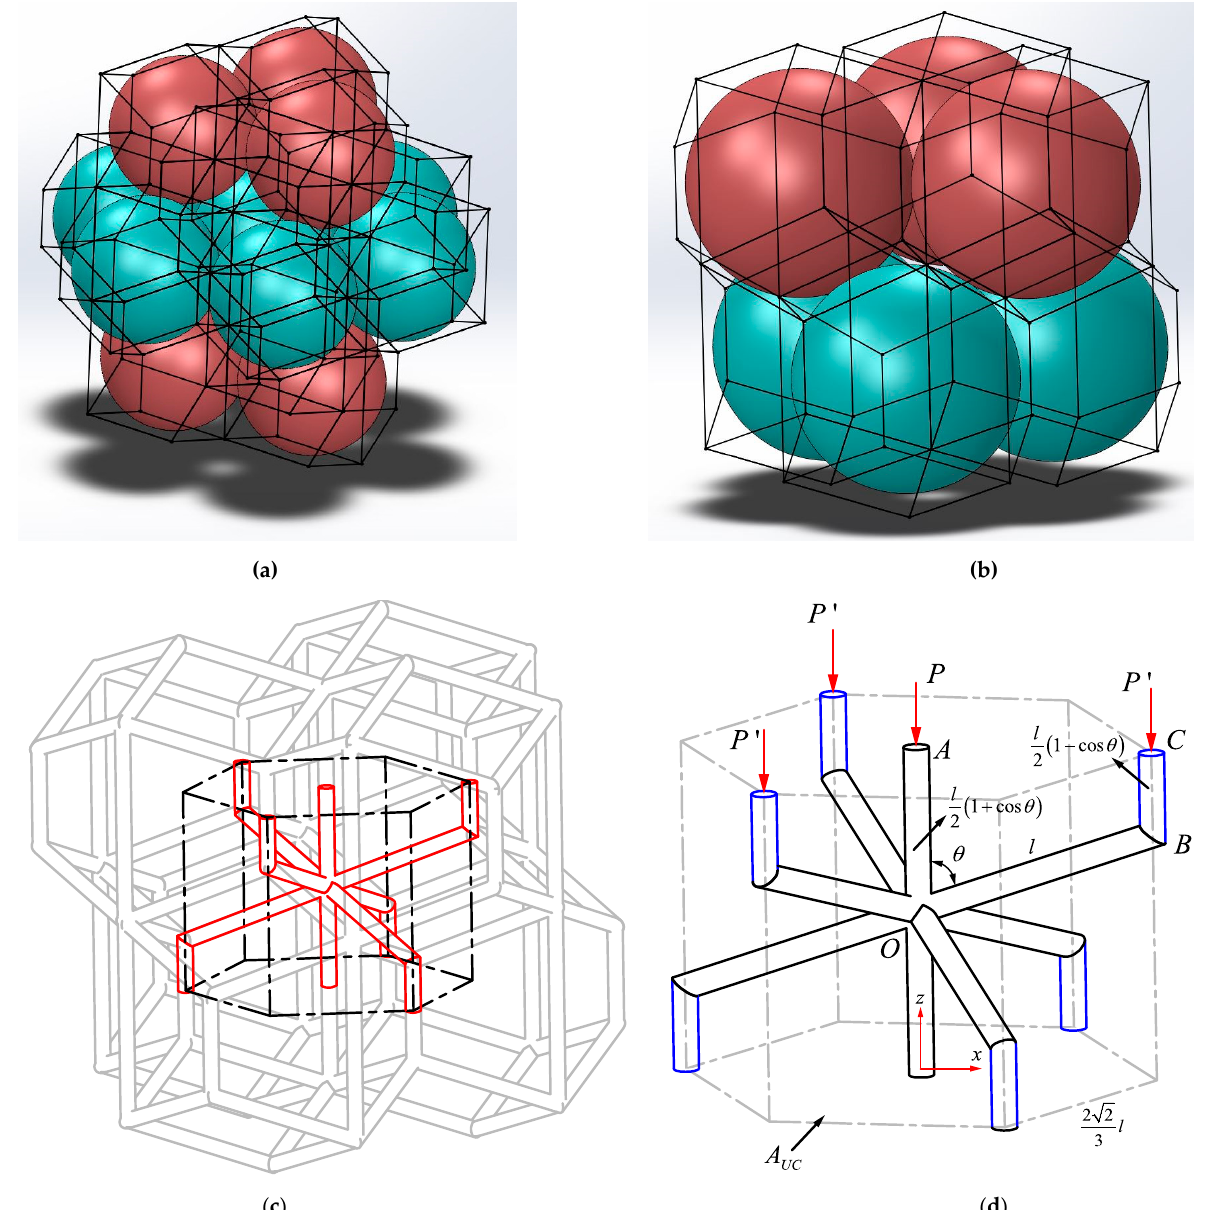
Figure A1. ( a ) Spherical hexagonal packing structure; ( b ) Simplified arrangement of spherical hexagonal packing; ( c ) A hexagonal packing unit cell in a lattice structure; ( d ) Dimensions and forces on a hexagonal packing unit cell.